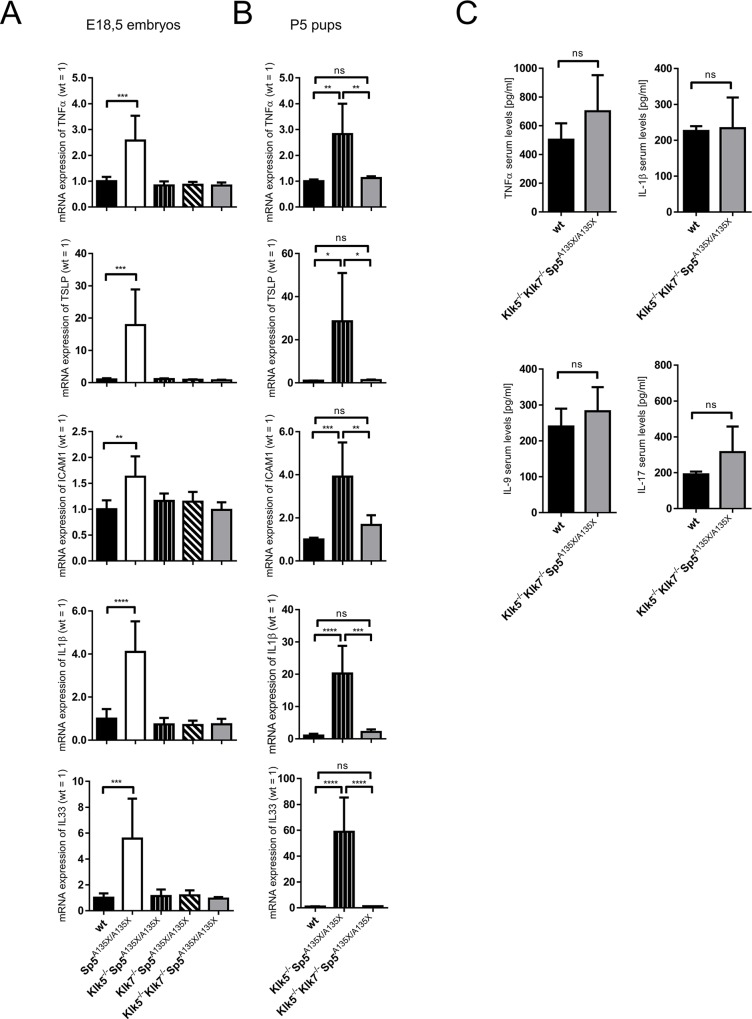
Analysis of cutaneous and systemic inflammation.(A) Expression of TSLP, TNFα, ICAM1, IL-1β and IL33 in the skin of E18.5 dpc wt, Sp5A135X/A135X, Klk5-/-Sp5A135X/A135X, Klk7-/-Sp5A135X/A135X, and Klk5-/-Klk7-/-Sp5A135X/A135X analysed by qRT-PCR, n≥5. Error bars represent standard deviations from mean; Data were analysed by One-way ANOVA followed by Bonferroni post-hoc tests. (B) Cytokine expression in the skin of P5 wt, Klk5-/-Sp5A135X/A135X, Klk5-/-Klk7-/-Sp5A135X/A135X and Klk5-/- analysed by qRT-PCR, n≥3. Error bars represent standard deviations from mean; Data were analysed by One-way ANOVA followed by Bonferroni post-hoc tests. (C) Analysis of serum levels of TNFα, IL-1β, IL-9 and IL-17 in 6 weeks old wt and Klk5-/-Klk7-/-Sp5A135X/A135X mice, n≥4. Error bars represent standard deviations from mean; Means were compared with a t-test, ns means “not significant“; * p < 0.05; ** p < 0.01; *** p < 0.001; **** p < 0.0001.